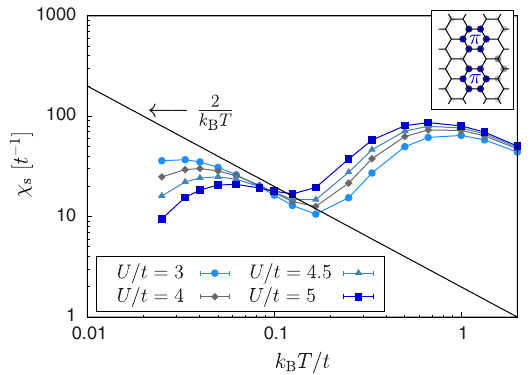
FIG. 7. Spin susceptibility as a function of temperature for two (cid:1) fluxes arranged as shown in the inset ( (cid:4)=t ¼ 0 : 2 , (cid:5) ¼ 0 , 9 (cid:4) 9 lattice). With increasing U=t , the strength of the interaction between spin fluxons increases, as revealed by the shift of the temperature below which deviations from a 2 Statistical errors are smaller than the symbol size. Inset: S (cid:2) ð i Þ for U=t ¼ 4 , using the same color coding as in Fig. 5(a).